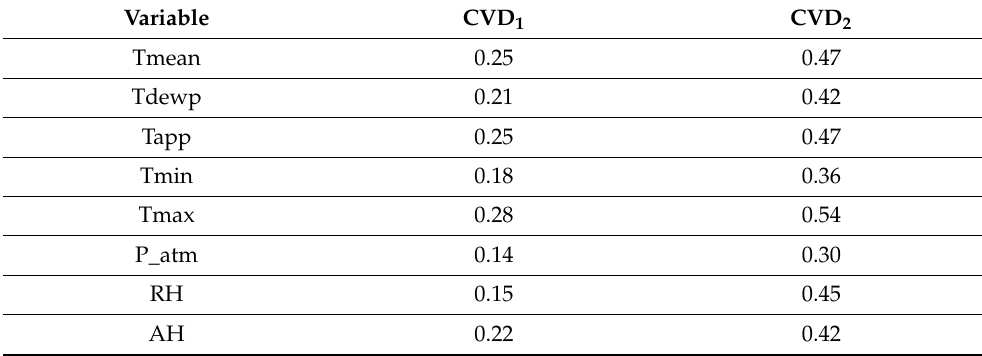
Table 8. Correlation between meteorological parameters and CVD admissions, with absolute